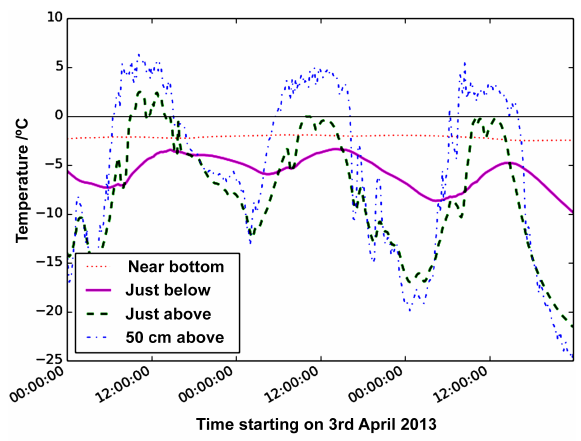
Figure 7. The snow and air temperatures measured by an FMI weather station at a swamp near Tähtelä, Sodankylä, a few kilome- tres from the airport. The bottom value is measured at the interface between snow and the ground. “Just below” refers to 1–9cm below the snow surface, and “just above” refers to 9–1cm above.